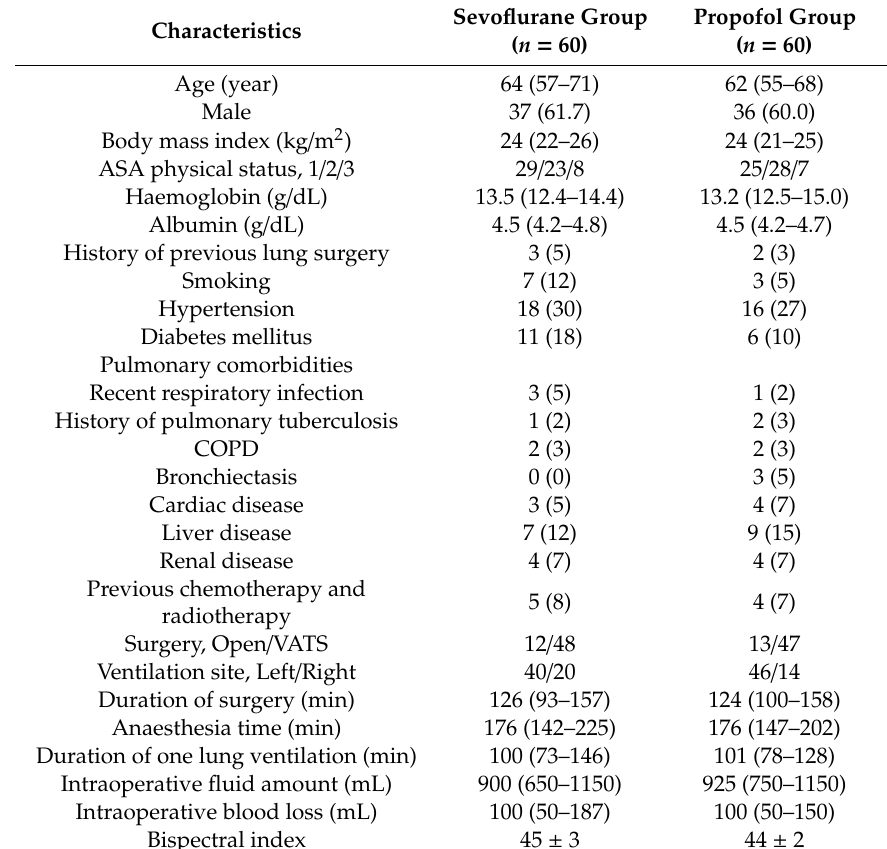
Table 1. Characteristics of patients between sevoflurane and propofol groups.